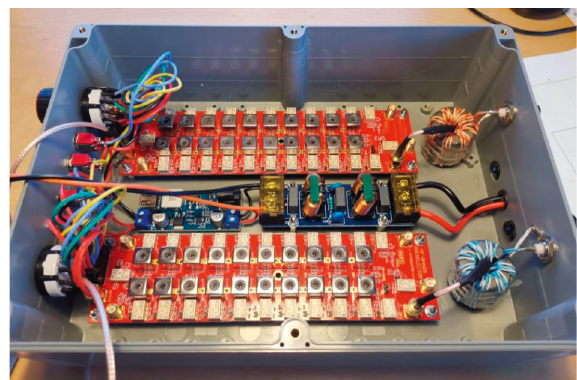
Figure 2: The assembled chokes and band-pass filters for both receiver chains.